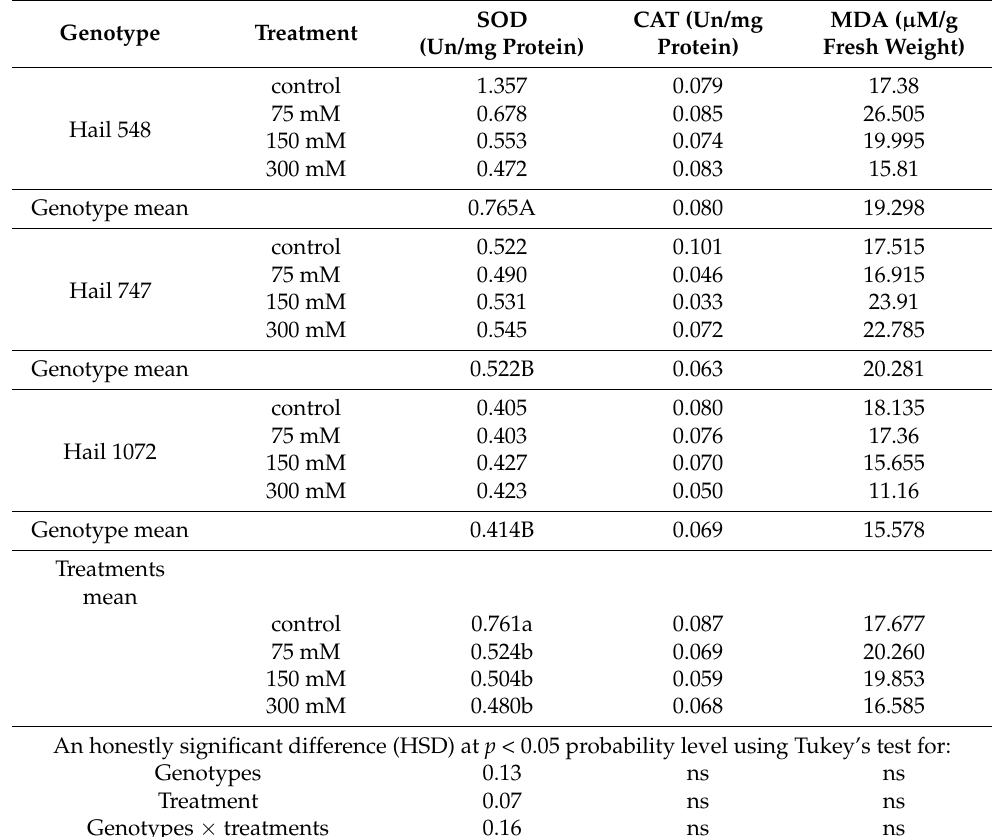
Table 4. Mean values of superoxide dismutase (SOD), catalase activity (CAT), and malondialdehyde (MDA) traits for three Hail landraces under four NaCl stress treatments. Values are the mean of four replications. According to Tukey’s test, different letters within the same columns show significant differences ( p < 0.05). The higher cases are the differences among genotypes, and the lower cases are the differences among treatments’ mean. ns: means not